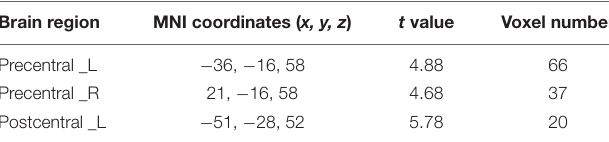
TABLE 5 | Brain regions showing significantly different FA between real and sham rTMS posttreatment.